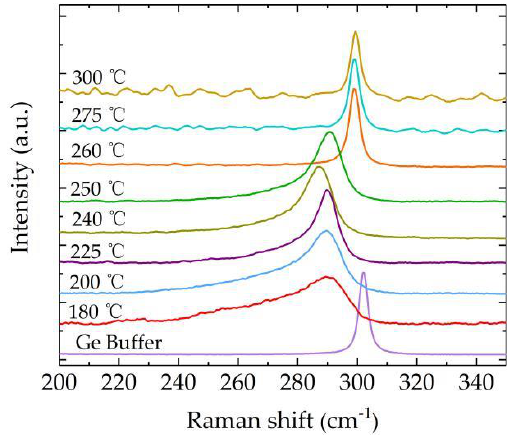
Figure 3. Ge-Ge Raman spectra of Ge 1 − x Sn x layers with different growth temperature.